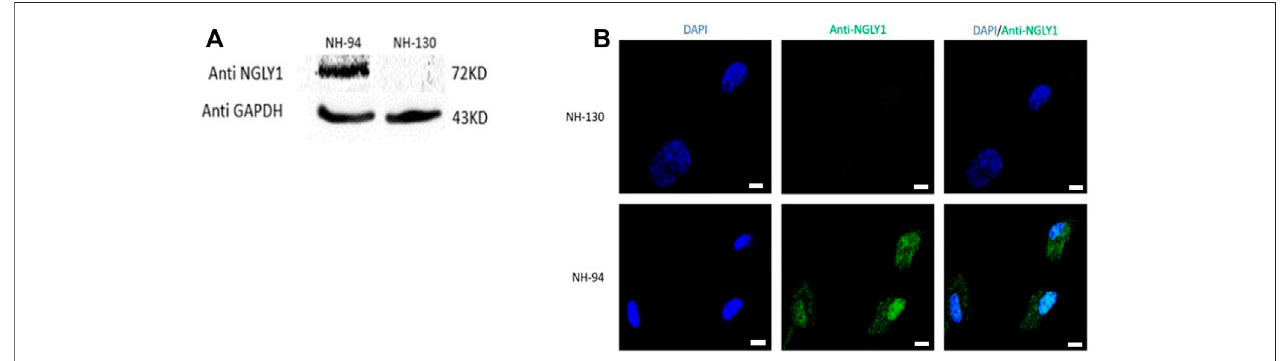
FIGURE 1 | NGLY1 protein levels are reduced in patients with NGLY1 de fi ciency. (A) WB analysis of NGLY1 protein with an antibody against human NGLY1, GAPDH was used as a loading control. (B) Immuno fl uorescence staining of NGLY1 protein level. Blue: DAPI, green: anti-NGLY1. NH-94 = healthy control; NH-130 = Patient. Scale bars- 20 µm.